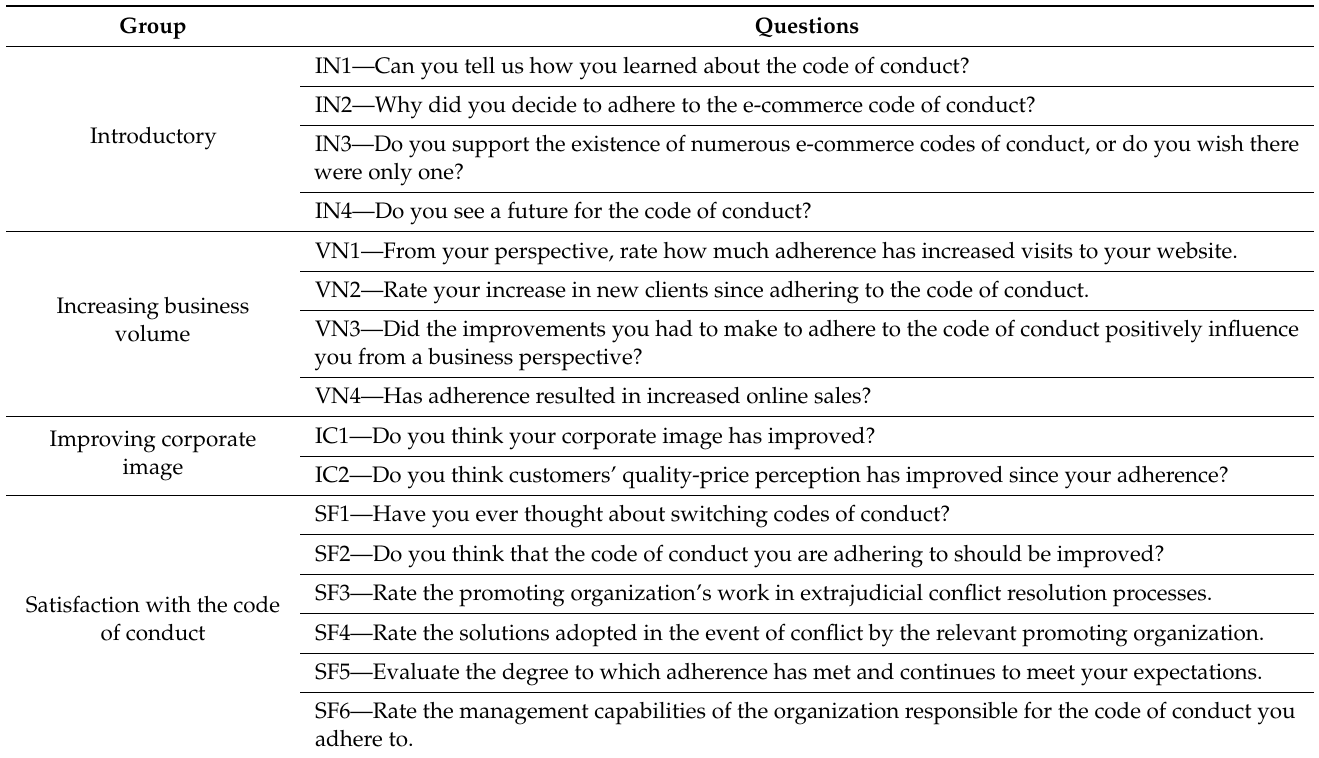
Table 3. Survey for Companies Adhering to a Quality